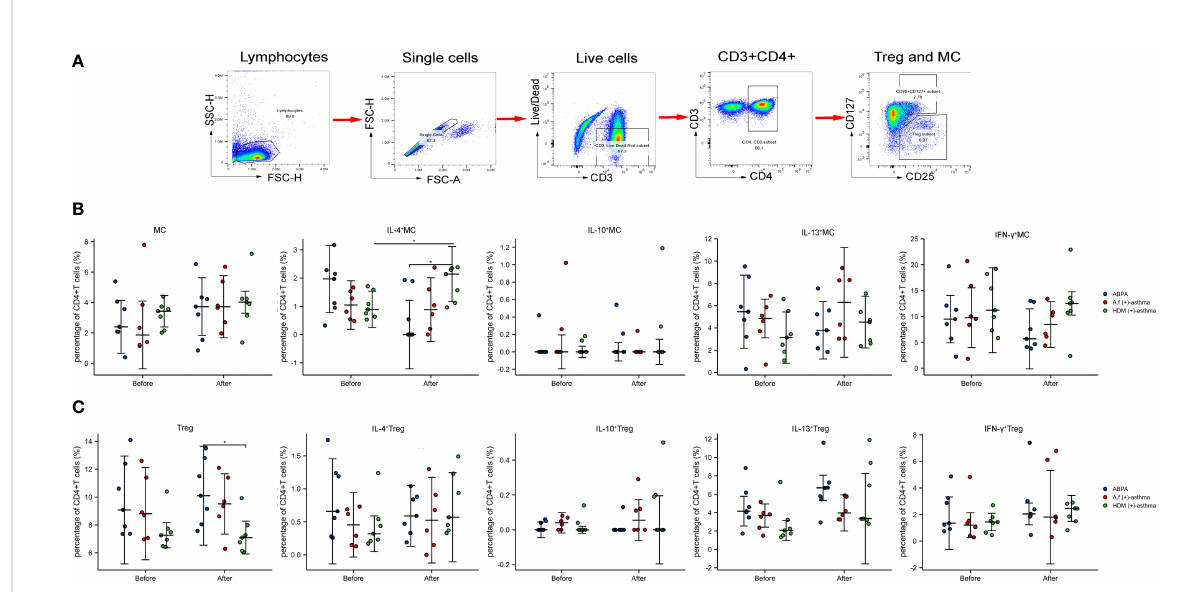
FIGURE 10 Treg (CD3 + CD4 + CD25 + CD127 low/ − ), metacluster (CD3 + CD4 + CD25 + CD127 + ), and their cytokines expression. (A) Manual gating strategy for metacluster (CD3 + CD4 + CD25 + CD127 + ); (B) the dot plot fi gures showed the percentage of Treg and the cytokines of the IL-4, IL-10, IL-13, and IFN- g ; (C) the percentage and cytokines (IL-4, IL-10, IL-13, and IFN- g ) of metacluster (CD3 + CD4 + CD25 + CD127 + ) are shown. MC, metacluster (CD3 + CD4 + CD25 + CD127 + ); ABPA, allergic bronchopulmonary aspergillosis; A.f (+) asthma, Aspergillus fumigatus -sensitized asthma; HDM (+) asthma, house dust mite-sensitized asthma; Th1, T helper cells 1; Th2, T helper cells 2; Tfh, follicular helper T cells; Treg, regulatory T cells; IFN- g , interferon g ; IL-4, interleukin 4; IL-13, interleukin 13; IL-10, interleukin 10.